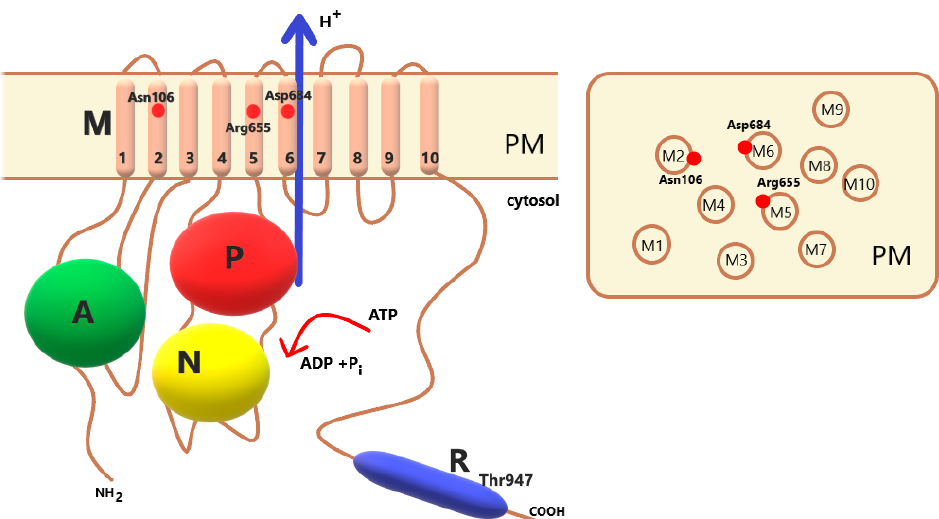
Figure 2. Schematic view of P-type ATPases. In the structure of PM H + -ATPase, we distinguish the A, M, P, N and R domains. Three cytoplasmic domains, phosphorylation (P, red), nucleotide binding (N, yellow) and actuator (A, green), are responsible for ATP hydrolysis. The M domain consists of the ten transmembrane helices. The C-terminal R domain contains the penultimate threonine (in AHA2 Thr947), which plays an important role in enzyme activation. On the right is a schematic view of the arrangement of the M1-M10 transmembrane domains in the plasma membrane. The red dots mark the amino acids that play a key role in the transport of protons (in AHA2, these are Asn106, Arg655 and Asp684).